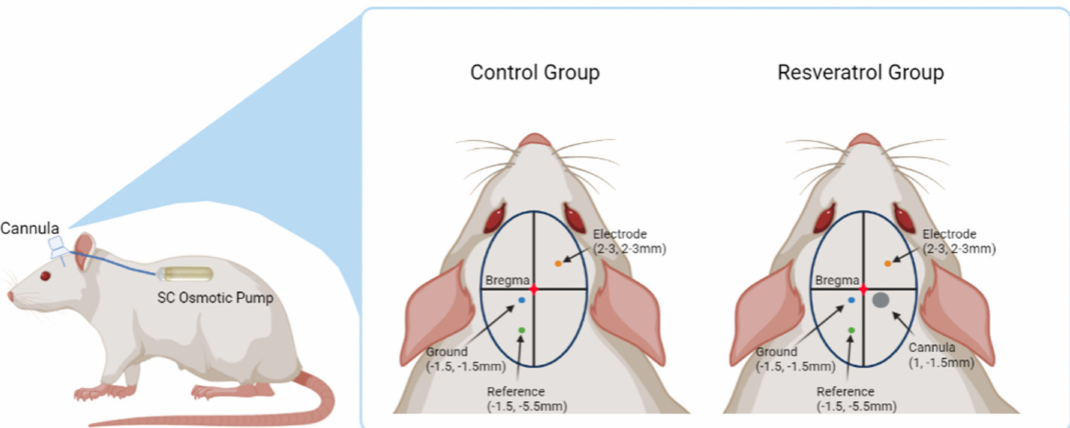
Figure 1. Illustration of the placement of all implanted components. The electrode (2–3 mm anterior and 2–3 mm lateral to bregma), ground (1.5 posterior and 1.5 lateral to bregma), and reference (5.5 posterior and 1.5 lateral to bregma) were implanted at the same coordinates for both the control and resveratrol group. The resveratrol group was additionally im- planted with the cannula at 1 mm posterior and 1.5 mm lateral to bregma. A subcutaneous pocket was made in the animal’s back to place to osmotic pump. Created with